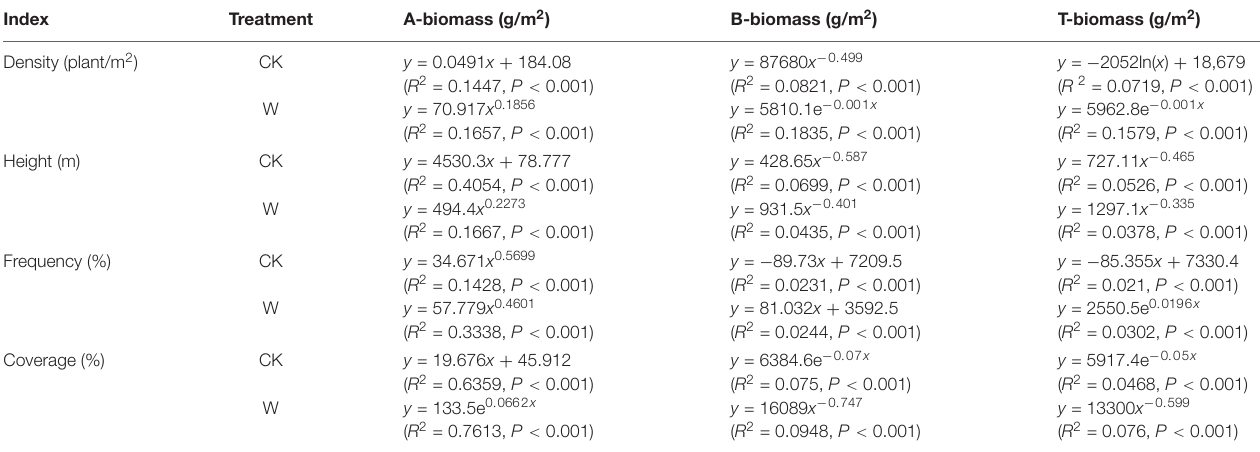
FIGURE 2 | The optimal correlations of plant biomass with (A–F) plant density, (G–L) height, (M–R) frequency, and (S–X) coverage under control (CK), and warming (W) treatments in an alpine meadow. A-biomass, B-biomass, and T-biomass indicate the aboveground, belowground, and total biomass, respectively. For each index (plant density, height, frequency, and coverage), CK and W graphs are shown in sequence for A-biomass, B-biomass, and T-biomass. For example, (A,B) show A-biomass for CK and W treatments followed by (C,D) for B-biomass for CK and W treatments. TABLE 2 | The optimal functional equation of plant biomass with plant density, height, frequency, and coverage under control (CK) and warming (W) treatments in an alpine meadow.